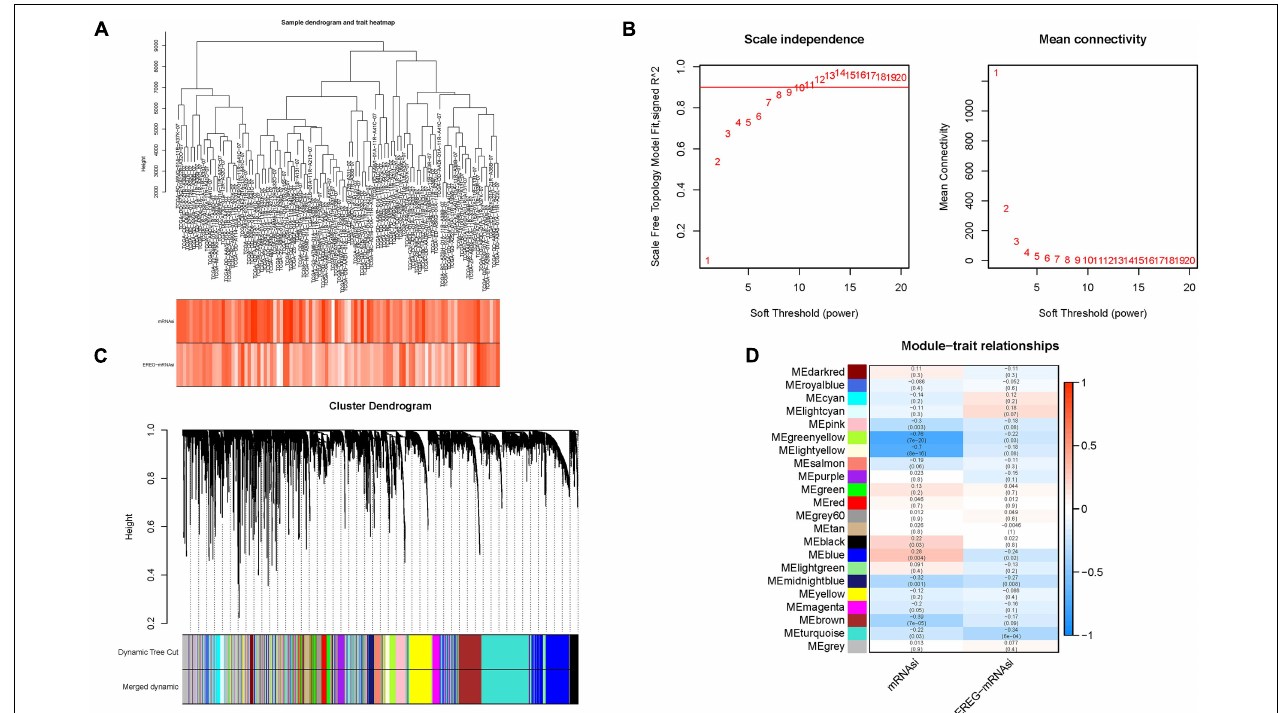
FIGURE 3 | Construction of weighted gene co-expression network of HCC samples. (A) Sample dendrogram and clinical-traits heatmap was plotted. (B) Selection of the soft threshold made the index of scale-free topologies reach 0.90 and analysis of the average connectivity of 1–20 soft threshold power. (C) mRNAsi-related genes with similar expression patterns were merged into the same module using a dynamic tree-cutting algorithm, creating a hierarchical clustering tree. (D) Heatmap of the correlations between the modules and mRNAsi as well as epigenetically regulated mRNA expression-based stemness index (EREG-mRNAsi) (traits). Within every square, the number on the top refers to the coefficient between the tumor mutation burden (TMB) level and corresponding module, and the bottom is the p -value.